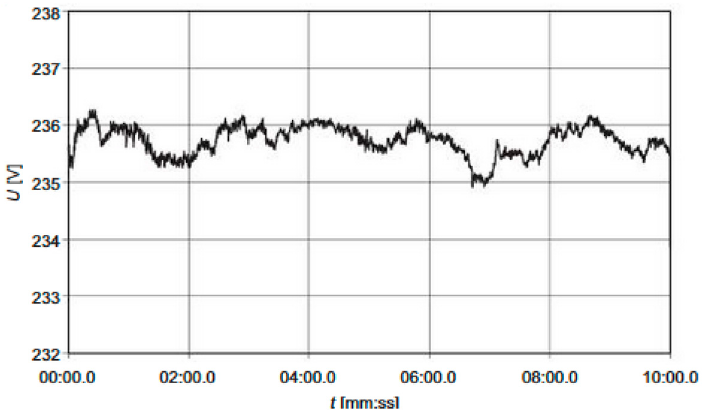
Figure 1. Changes in rms value voltage at the terminals of the wind turbine [18].